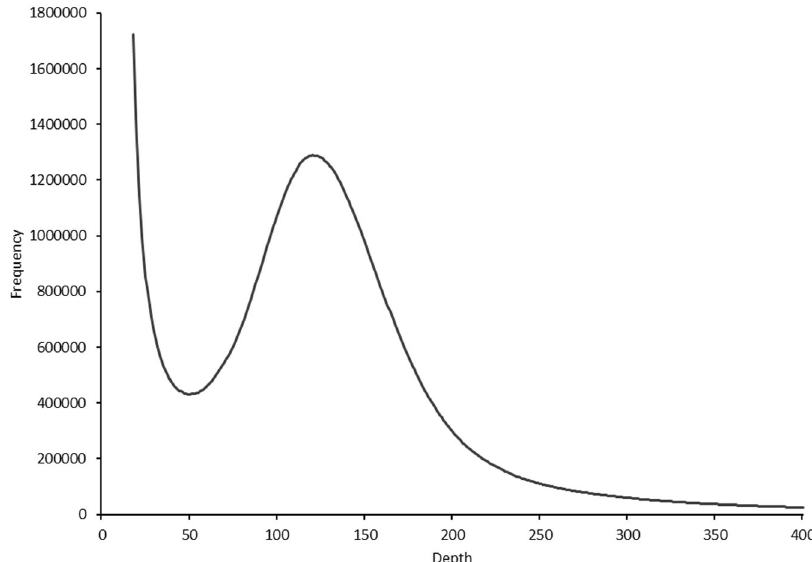
Fig. 2 K- mer distribution of Illumina sequencing reads of Ips typographus . The peak k -mer depth ( k = 19) was 124, giving an estimated haploid genome length of 221,929,798 bp. The presence of a single peak suggests a highly homozygous genome. Table 1 Assembly statistics of the Ips typographus genome. Comparisons with I. typographus and two other Coleoptera species, Dendroctonus ponderosae and Tribolium castaneum